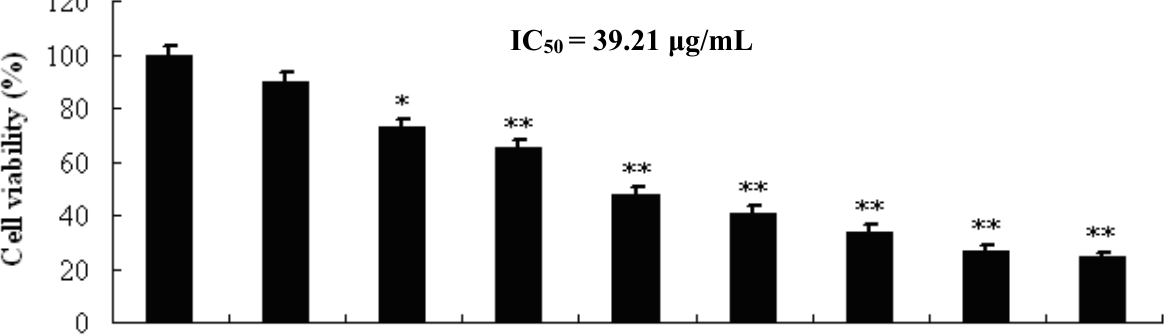
Figure 2. Proliferation inhibiting effects of SBT-A on A549 cells. A549 cell lines were treated with low to high concentrations of SBT-A (10, 20, 30, 40, 50, 60, 70 and 80 μ g/mL) for 48 h, and cells proliferation was determined by MTT assay. The IC The data are represented as mean ± S.D ( n = 4). * p < 0.05 and ** p < 0.01 vs .